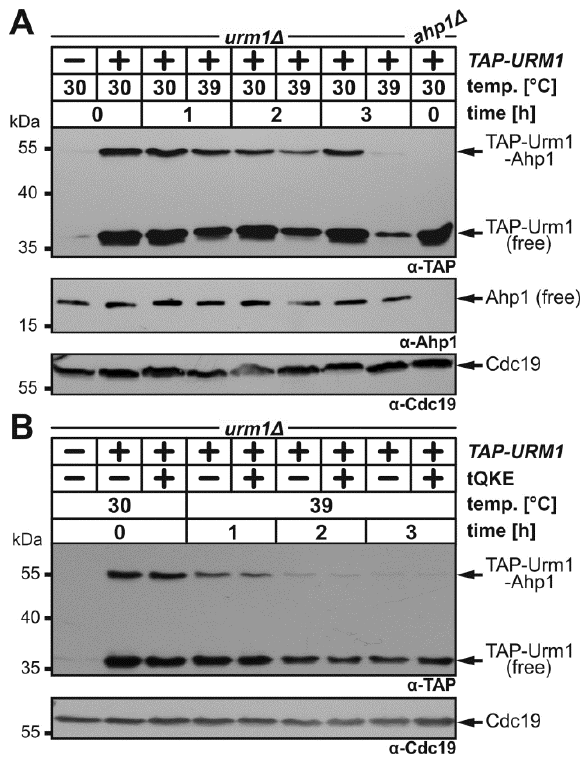
FIGURE 2: Overexpression of tRNAs subject to Urm1-dependent U34 thiolation fails to suppress loss of Ahp1 urmylation at 39°C. (A) Urmylation of Ahp1 is suppressed at 39°C. An urm1 ∆ strain